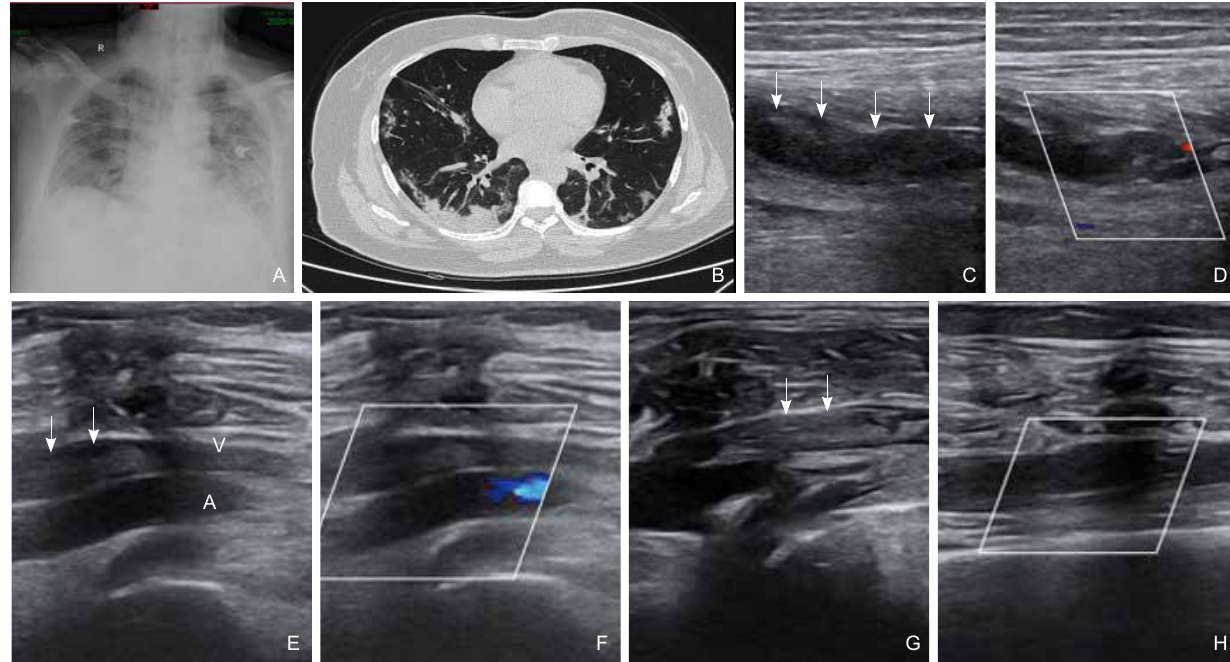
Figure 2 Bedside ultrasound showing venous thrombosis of both lower extremities. A 64-year-old female patient was hospitalized with fever and cough aggravation for 7 days. Covid-19 nucleic acid was positive, oxygen saturation was 65%, and ventilator assisted respiration into ICU. (A) X-ray of chest shows patchy shadows of right lung and left middle and lower lung fields, according to the change of viral pneumonia on both sides. (B) CT the lung of shows diffuse distribution of ground glass shadow and grid strip shadow. (C,D) Bedside ultrasound showed thrombosis in popliteal vein (shown by white arrow), CDFI showed no blood flow signal distribution. (E,F) Thrombosis in posterior tibial vein (shown by white arrow), CDFI showed no blood flow signal distribution, posterior tibial artery showed blood flow signal. (G,H) Intramuscular venous thrombosis (shown by the white arrow), CDFI showed no blood flow signal distribution. A, Posterior tibial artery; V, posterior tibial